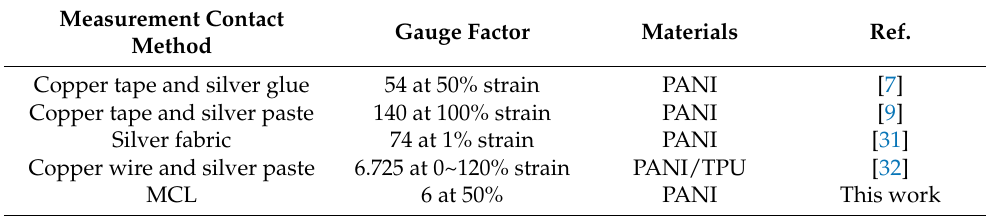
Table 1. The comparison of the measurement contact method of PANI-based strain sensors.